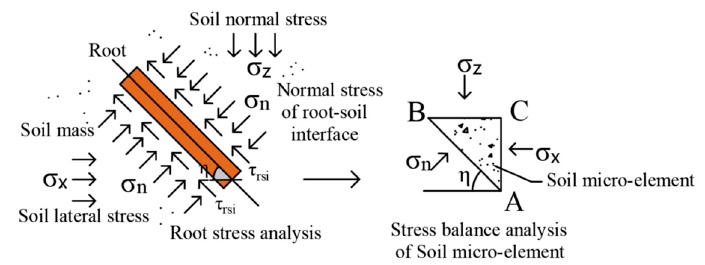
Figure 17. Schematic diagram of stress analysis of root–soil interface.